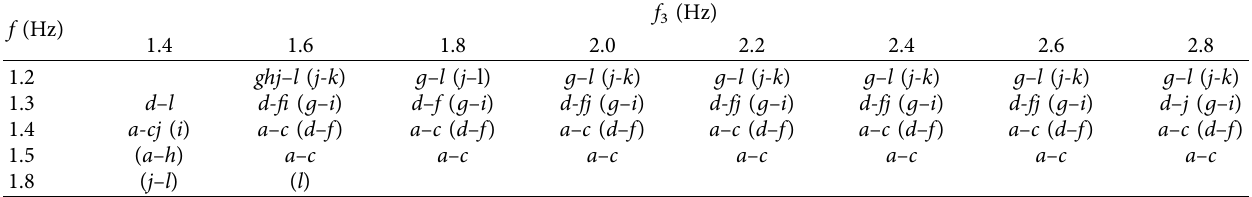
Table 8: The peak of structural dynamic response corresponding to f with three kinds of model.